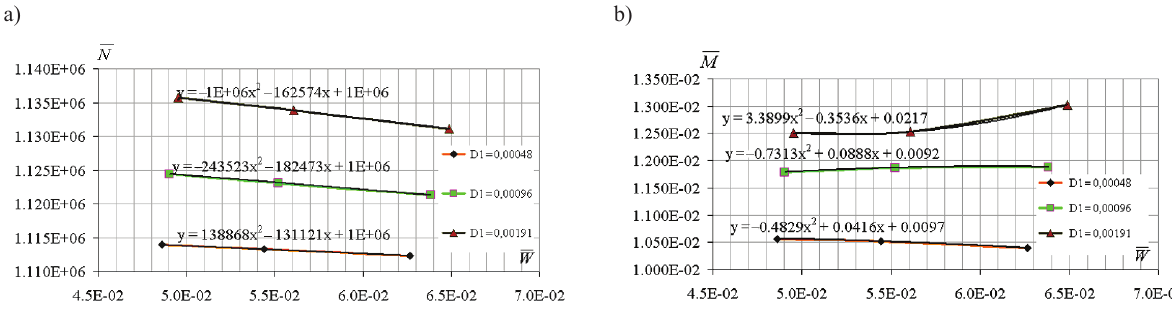
Fig. 3. Dependences of dimensionless parameters on the displacement: а) dependence of N ( W ) for the inner contour; b) dependence of M ( W ) for the inner